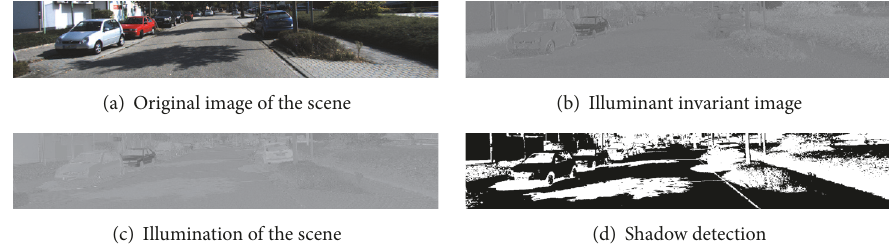
Figure 3: Partial results during the shadow detection. The process generates an illuminant invariant image and also an image with the illumination of the scene. The use of both images makes the system able to detect the shadows of the scene.